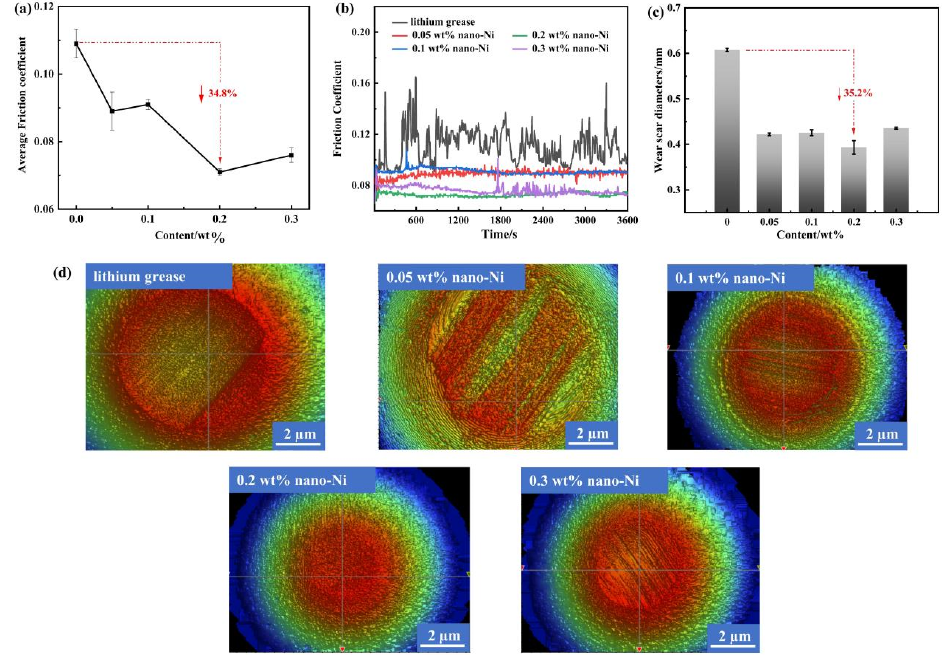
Figure 5. Tribological properties of the pure lithium grease and Ni-doped lithium grease under point-to-point contact: ( a ) Average COF; ( b ) COF curves; ( c ) Average WSD; ( d ) WLI morphologies of wear scar.